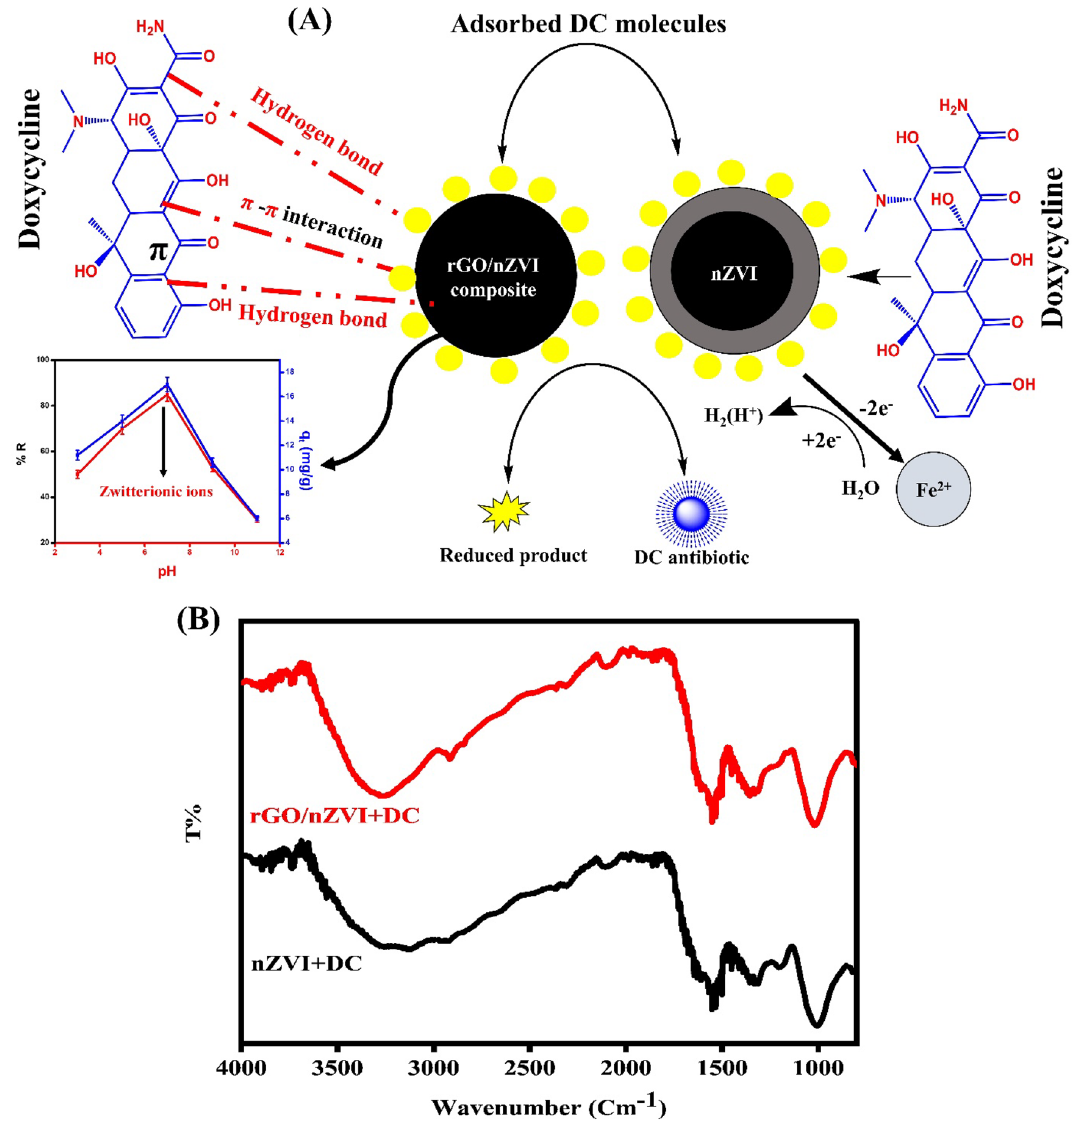
Figure 10. Plausible adsorption mechanism for the removal of DC antibiotic by rGO/nZVI composite and nZVI ( A ). FTIR spectra for the adsorption of DC onto rGO/nZVI and nZVI ( B